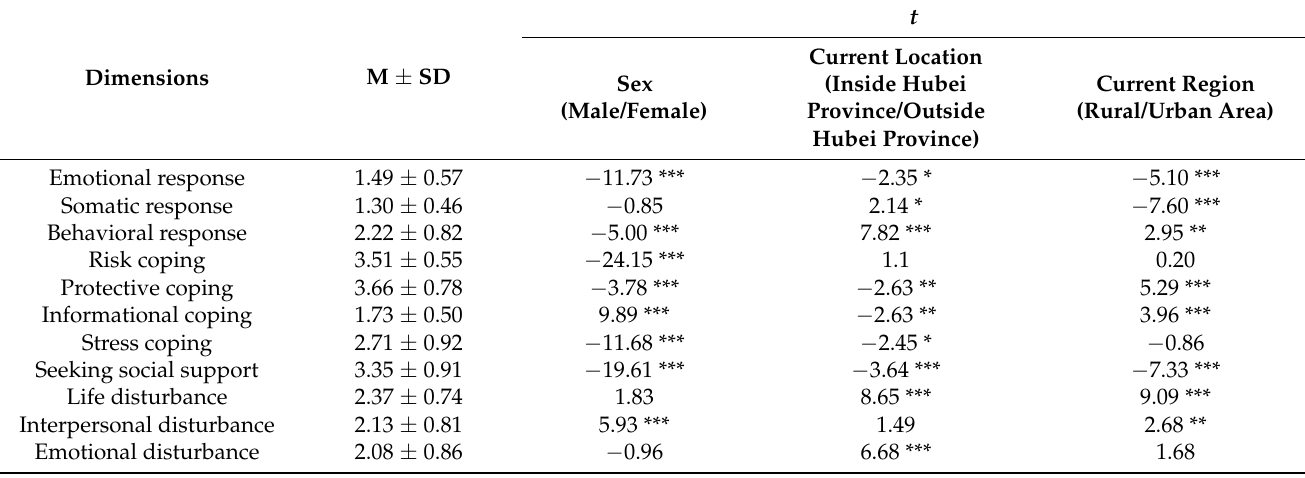
Table 3. Independent samples t -tests on demographic variables of psychological stress in college students ( n =